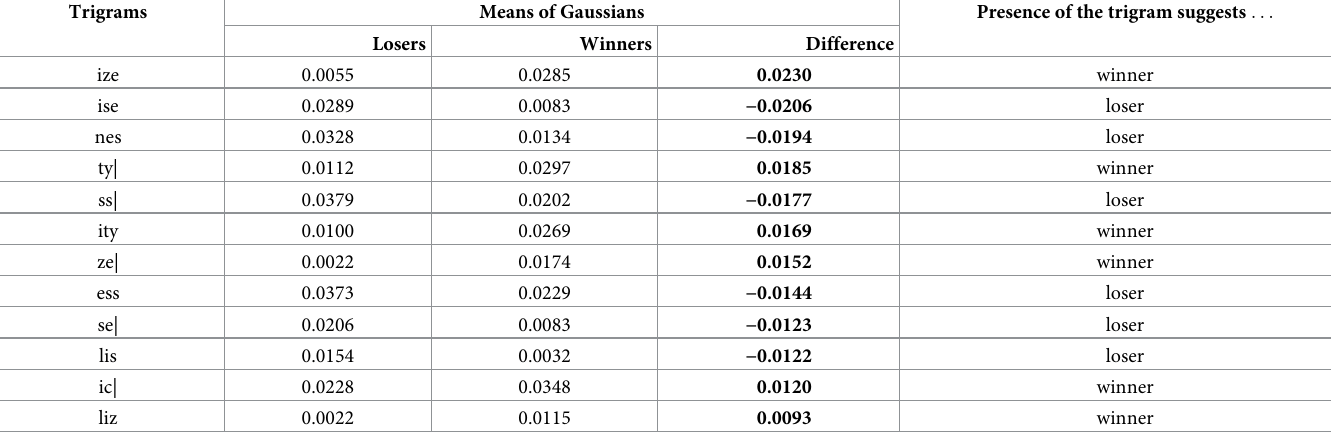
Table 12. Analysis of the unique ngrams features in the naive Bayes models for Test1. The table lists the top dozen trigrams with the greatest separation between the means. Differences that are statistically significant are marked in bold; all of the differences are significant. Significance is measured by a two-tailed unpaired t test with a 95% confidence